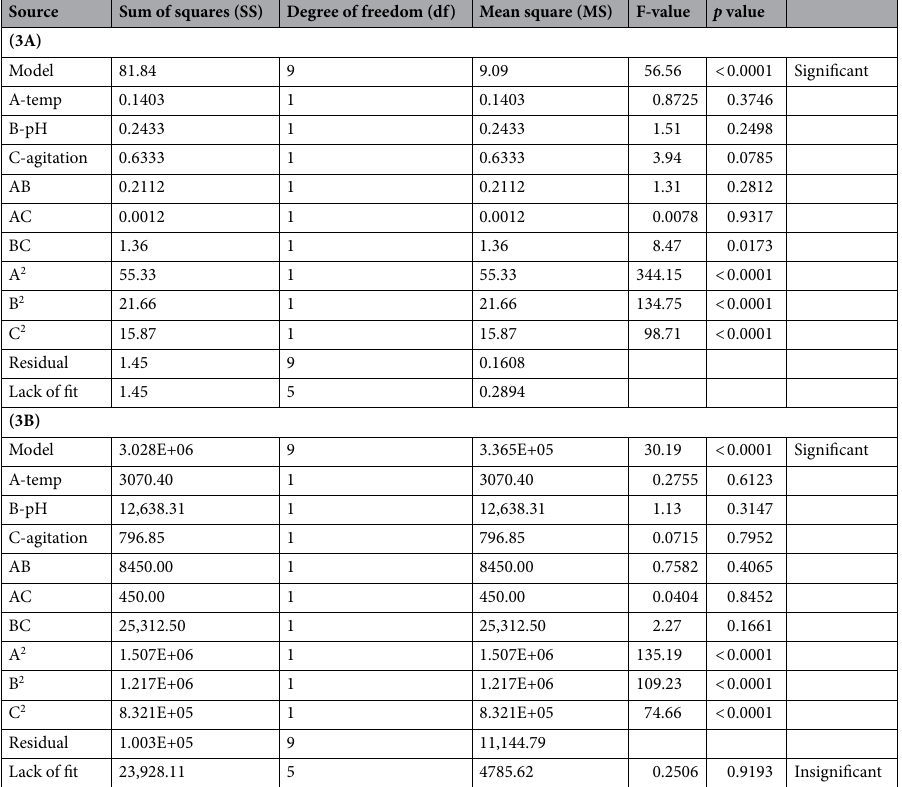
Table 3. Analysis of variance (ANOVA) of quadratic model for cell growth of E. coli BL21 (3A) and CMCase activity